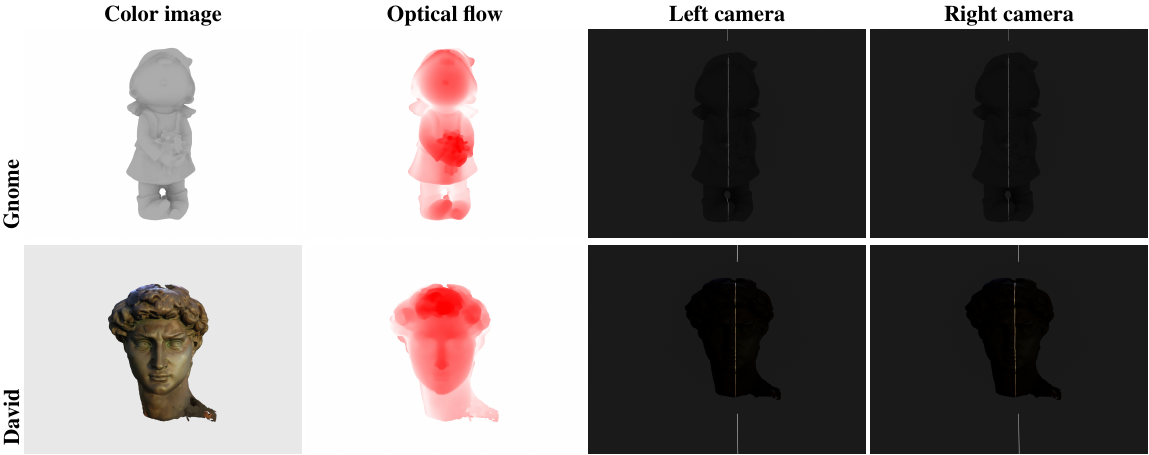
Figure 2. Examples from the ZebraScan Synthetic dataset.